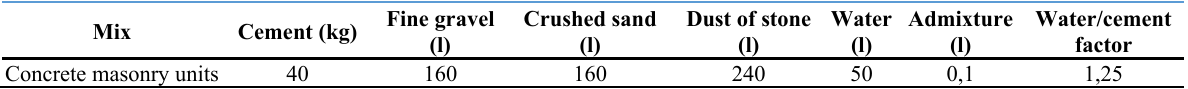
Table 2. Mix proportion of the concrete